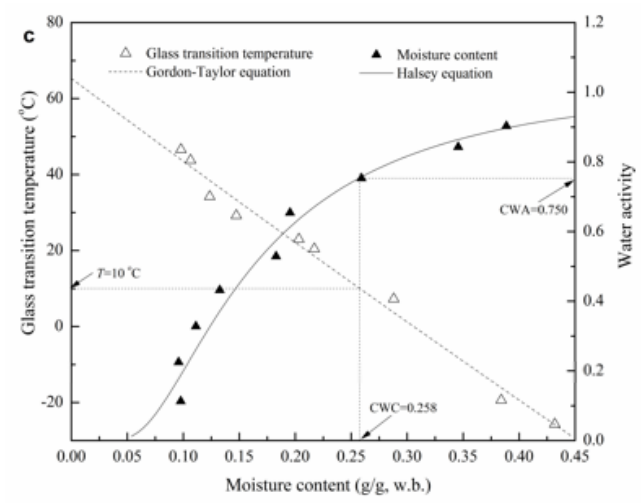
Figure 5. Variation of glass transition temperature, water activity with moisture content of GG ‐ based films; ( a ) GG ‐ P, ( b ) GG ‐ G, and ( c ) GG ‐ G ‐ N.